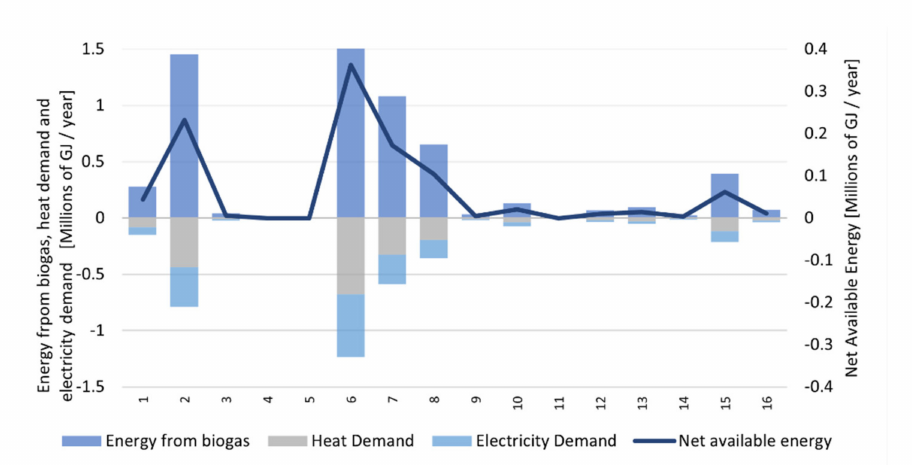
Figure 7. Energy balance of each region when treating CrM residue by anaerobic